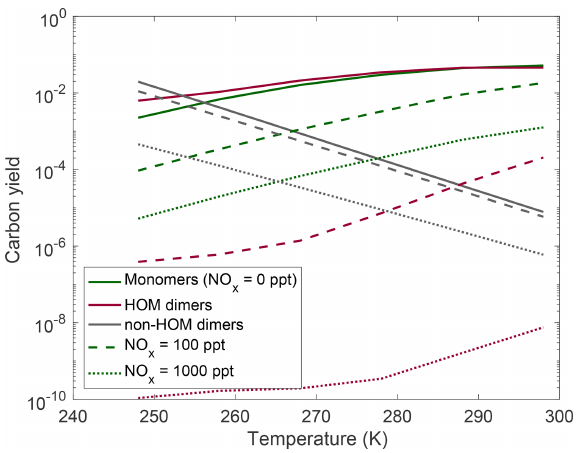
Figure 7. Yields at different temperatures and various NO x lev- els: no NO x present (solid curves), 100ppt of NO x present (dashed curves), and 1000ppt of NO x present (dotted curves). Very low NO x concentrations have little effect on HOM yields; however, NO x eventually becomes competitive with HOM-producing path- ways, and there is a significant reduction in both dimer and HOM monomer yields accompanied by an increase in non-HOM dimers. HOM dimers are more strongly affected by suppression of autoxi- dation than HOM monomers.